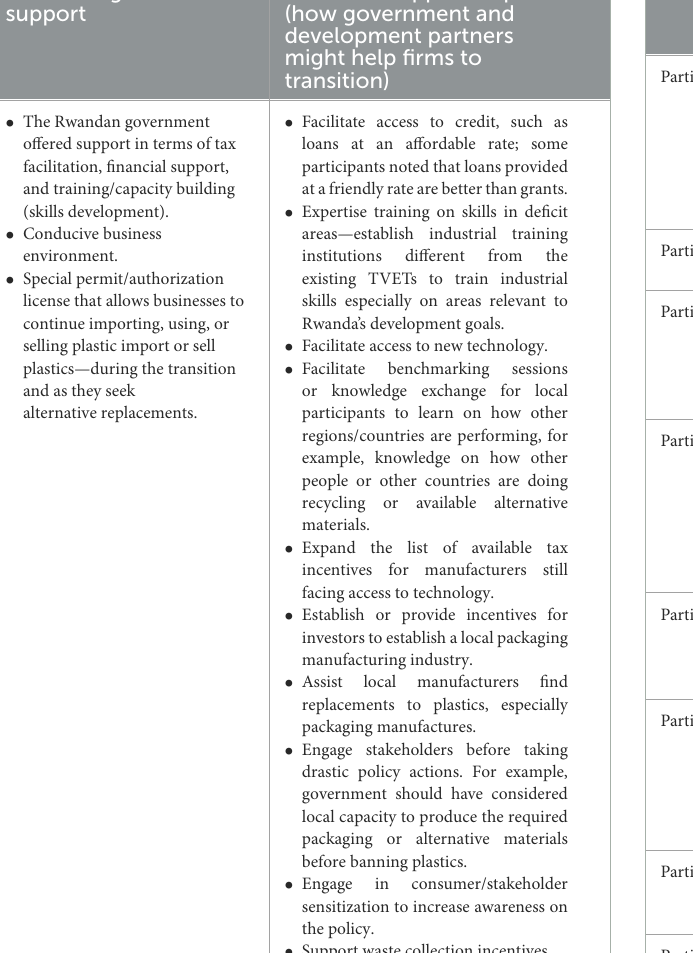
TABLE 6 Strategies adopted by Rwanda manufactures as they transition from single-use plastics to other alternatives.